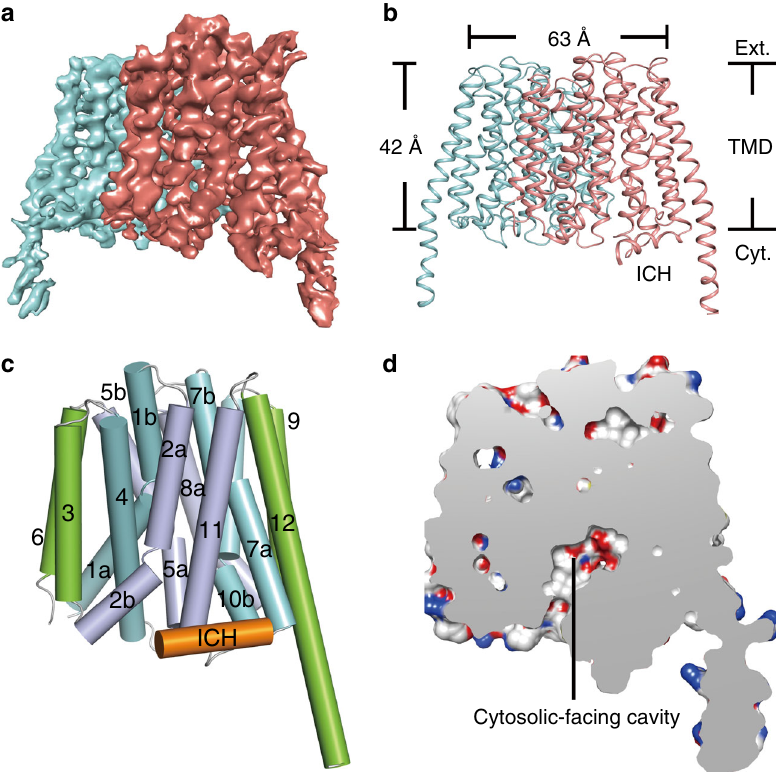
Fig. 2 Structure of human MCT2. a A 3D reconstruction of MCT2 with each subunit individually colored in cyan and magenta. b Cartoon diagrams of MCT2 dimer in the same orientation as the electron microscopy map in a . Ext, TMD and Cyt mean extracellular side, transmembrane domain and cytoplasmic side. c The structure of MCT2 subunit in an inward-open conformation viewed parallel to the membrane. The corresponding transmembrane segments in the four 3-helix repeats are colored the same. The intracellular helix is colored as orange, respectively. d A slab of cut-open view of the surface is shown to facilitate visualization of the inward-facing